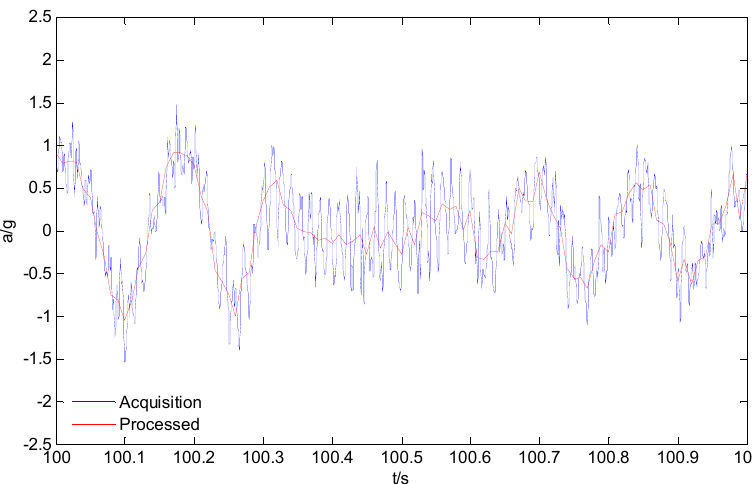
Figure 8. Acceleration response histories before and after